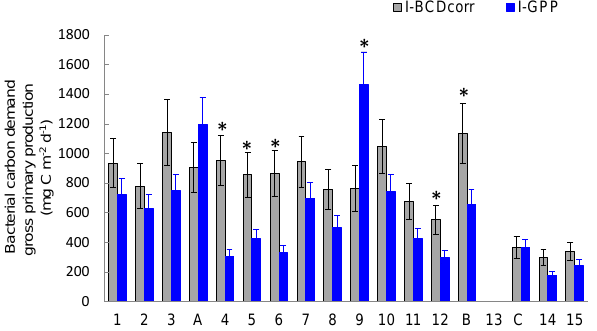
Figure 10. Distribution of integrated bacterial carbon demand cor- rected for Prochlorococcus assimilation (I-BCD corr , grey bars) gross primary production derived from IPP deck (I-GPP, blue bars), along the transect. Error bars are standard errors (SE), calculated using propagation of errors. We included analytical SE (triplicate measurement at each depth for PP and BP), SE due to daily BP variability, SE from BGE, and SE due to leucine assimilation by Prochlorococcus . ∗ Shows stations in which I-BCDcorr minus I- GPP was statistically different from